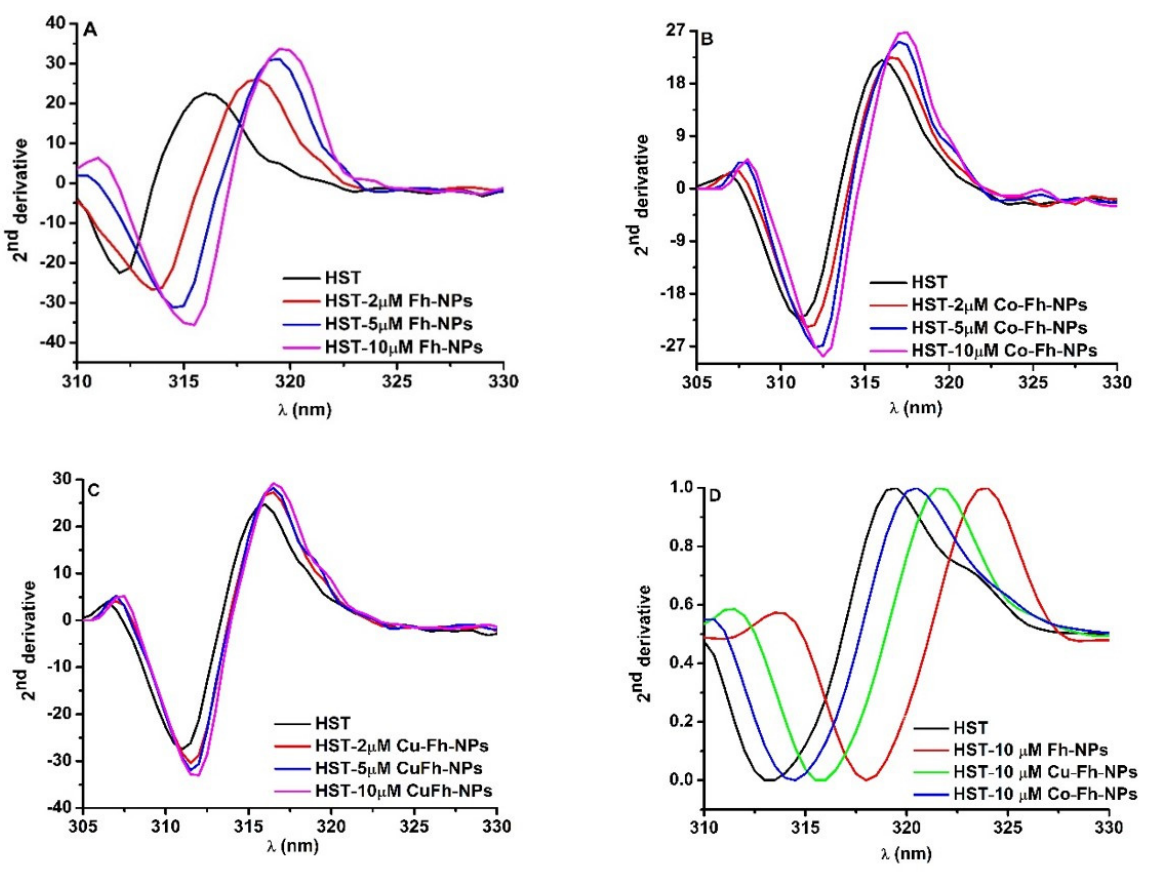
Figure 2. ( A – C ): The second derivatives of the Trp emission spectra of HST at different Fh-NPs, Cu-Fh-NPs and Co-Fh-NPs concentrations (0, 2, 5 and 10 µ M) and ( D ): The second derivative of the Trp emission spectra of HST (black curve) and HST in the presence of 10 µ M Fh-NPs (red curve), Cu-Fh-NPs (green curve) and Co-Fh-NPs (blue